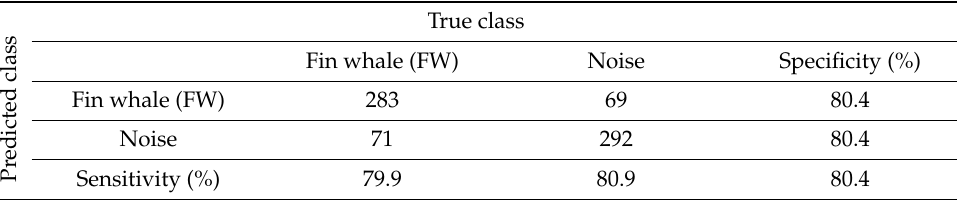
Table 7. The confusion matrix associated with the comparison method I for the ‘Fin whale (FW) + Noise’ dataset (the accuracy (%) is indicated in bold font and calculated as a ratio of the sum of diagonal values to the sum of all values ×